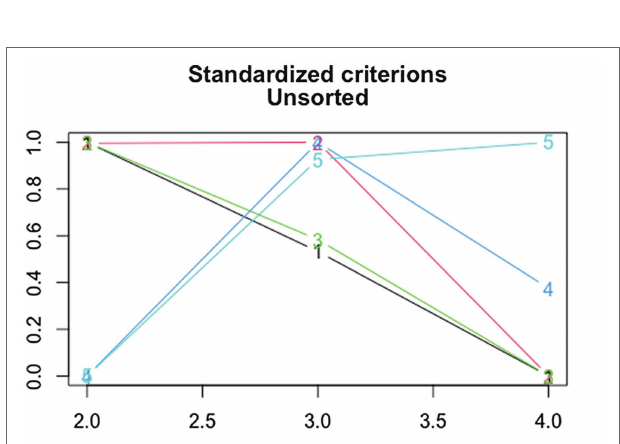
FIGURE 2 | Three-cluster solution from kml. The first cluster of subjects (colored red) contains the majority (56%) of the subjects ( n = 62) and can be described as “stable low.” The second cluster (colored blue) contains 22% of the subjects ( n = 24) and can be described as “high decreasing.” Finally, the third cluster (colored green) contains 22% of the subjects ( n = 24) and can be described as “low increasing.”